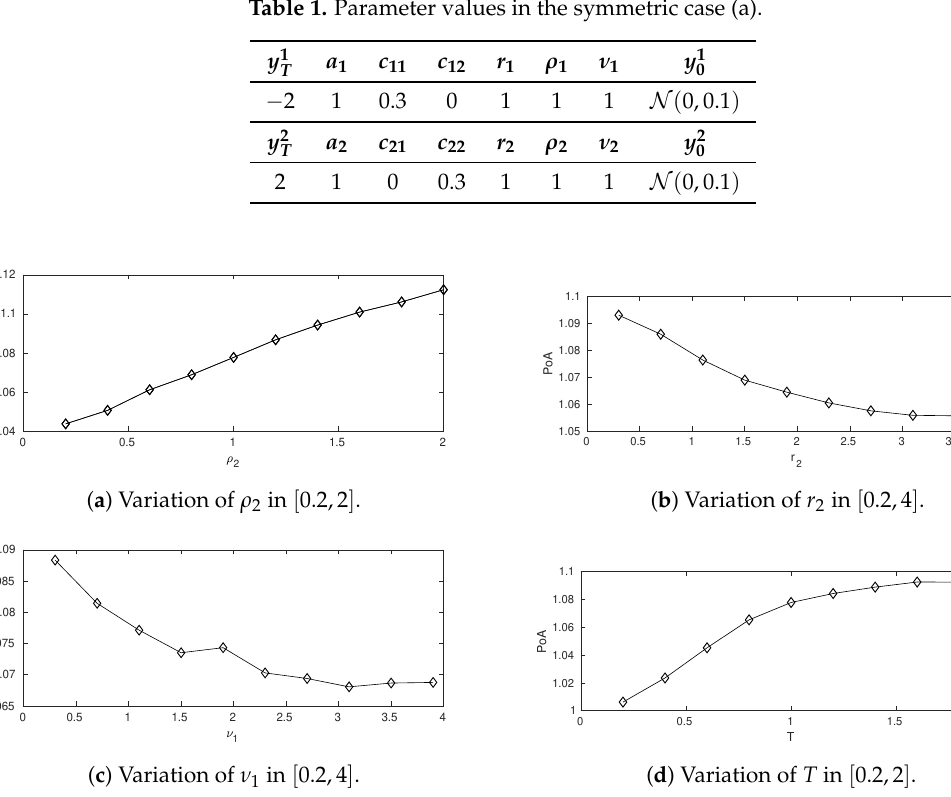
Figure 2. Numerical approximations ( N = 5000) of the price of anarchy PoA